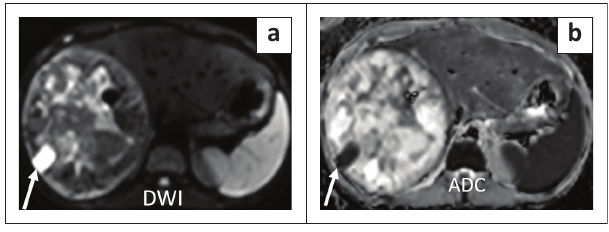
DWI, diffusion-weighted images; ADC, apparent diffusion coefficient. FIGURE 4: (a) Axial diffusion-weighted images image at b = 800 sec/mm 2 shows heterogeneous content with hyperintensity areas that reveal low signal on the corresponding apparent diffusion coefficient map (b), indicating diffusion restriction. This was related to the internal haemorrhage and necrotic tissue. White arrows mark a focal haemorrhagic focus ( marked T1 hyperintensity as seen in Figure 3C ), showing significant restricted diffusion.